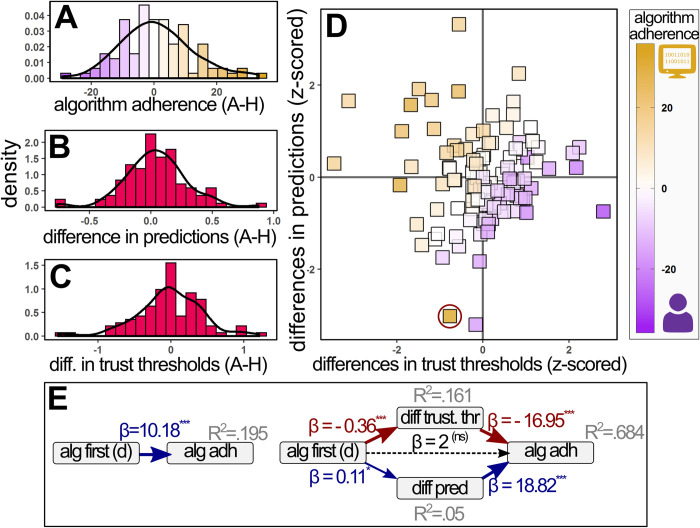
Experiment results.Icons indicate the direction of affinity for human or algorithmic fund-managers. A: the distribution of observed algorithm adherence values, calculated as the participants’ difference in investment rates between algorithm- and human-managed funds. Higher values indicate higher algorithm adherence. B: the distribution of participants’ differences in predictions, calculated as the participants’ difference in mean predicted returns of algorithmic- versus human-managed funds. Higher values indicate a higher relative prediction for the return of funds managed by algorithmic managers. C: the distribution of participants’ differences in trust thresholds, calculated as the predicted return required for the participant to be indifferent towards investing in an algorithmic manager’s fund versus a human manager’s fund. Higher values indicate a higher relative threshold against investing in an algorithm-managed fund. D: scatterplot depicting the relationship between all three main variables. The x-axis denotes the difference in trust thresholds, the y-axis denotes the difference in predictions and the color indicates the level of algorithm adherence. The red circle indicates an outlier participant. E: SEM model results for the direct effect of presentation order on algorithm adherence (left) and mediated model (right).